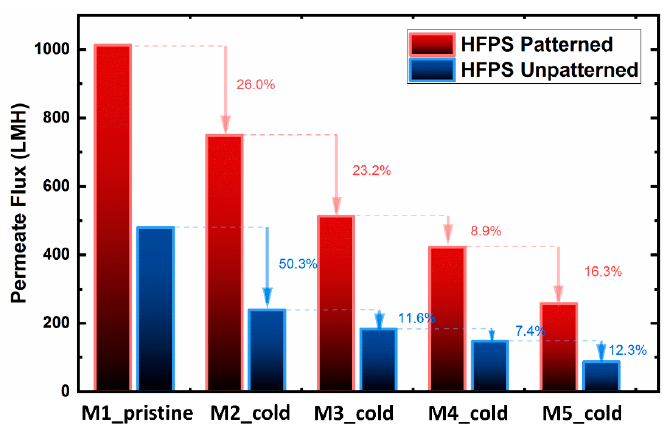
Figure 5. The effect of the cold treatment process on the filtration performance of HFPS patterned and unpatterned membranes prepared from the same hydrogel molds for five castings.